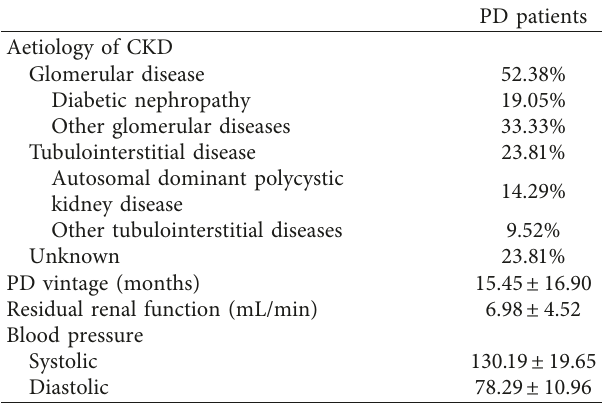
Table 1: Aetiology of chronic kidney disease (CKD), peritoneal dialysis (PD) vintage, residual renal function, and blood pressure of PD patients.